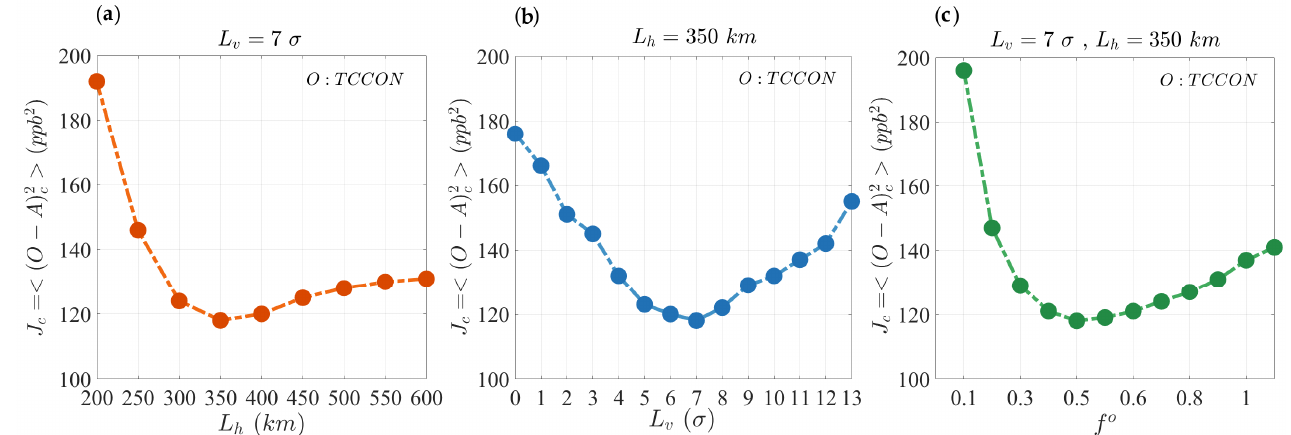
L , ( b ) vertical correlation length, L Figure 4. Estimation of the ( a ) horizontal correlation length, Figure 4. Estimation of the ( a ) horizontal correlation length, L h , ( b ) vertical correlation length, L v , h v and ( c ) observation error covariance parameter, f o , using independent TCCON observations with the , and ( c ) observation error covariance parameter, o f , using independent TCCON observations with (cid:68) (cid:69) ( O − A ) 2 cross-validation cost function, J = the cross-validation cost function, 2 ( ) J O A = − .